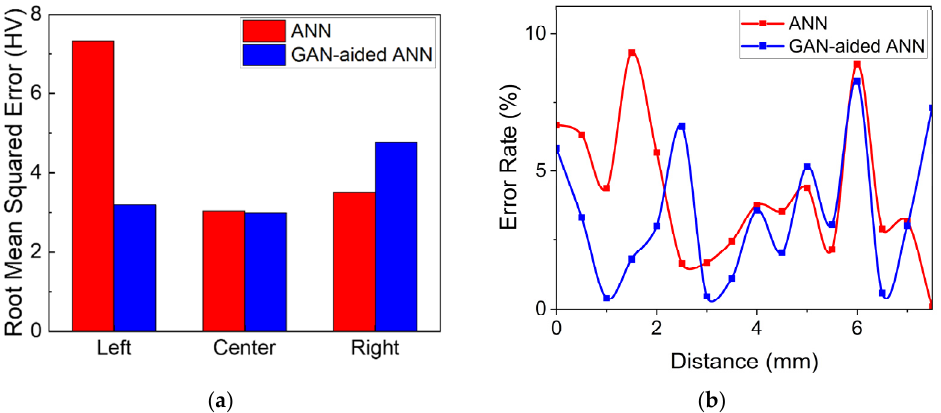
Figure 6. Comparing predictability for Vickers microhardness between ANN and GAN-aided ANN approaches: ( a ) RMSE values for the left section (0–2 mm in distance from the left edge), center (2–5.5 mm), and right section (5.5–7.5 mm); ( b ) the variation in error rates per datum as a function of distance.